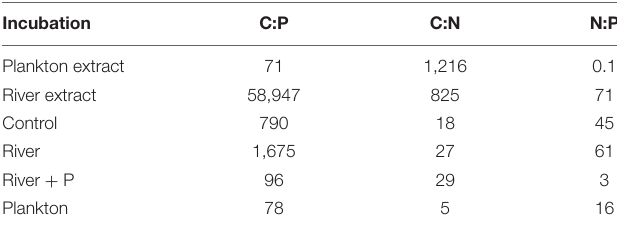
TABLE 1 | C, N, and P stoichiometry (moles) of the plankton and river extracts, and start values in the Control, River, River + P, and Plankton incubations in the microcosm